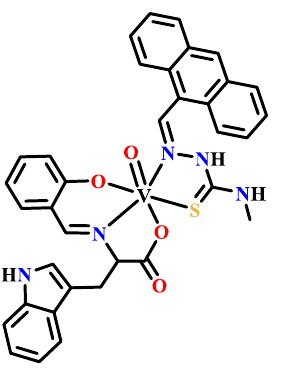
Figure 39. A vanadium(IV) complex of 9-anthrahydrazone with methylthiourea as a side chain.